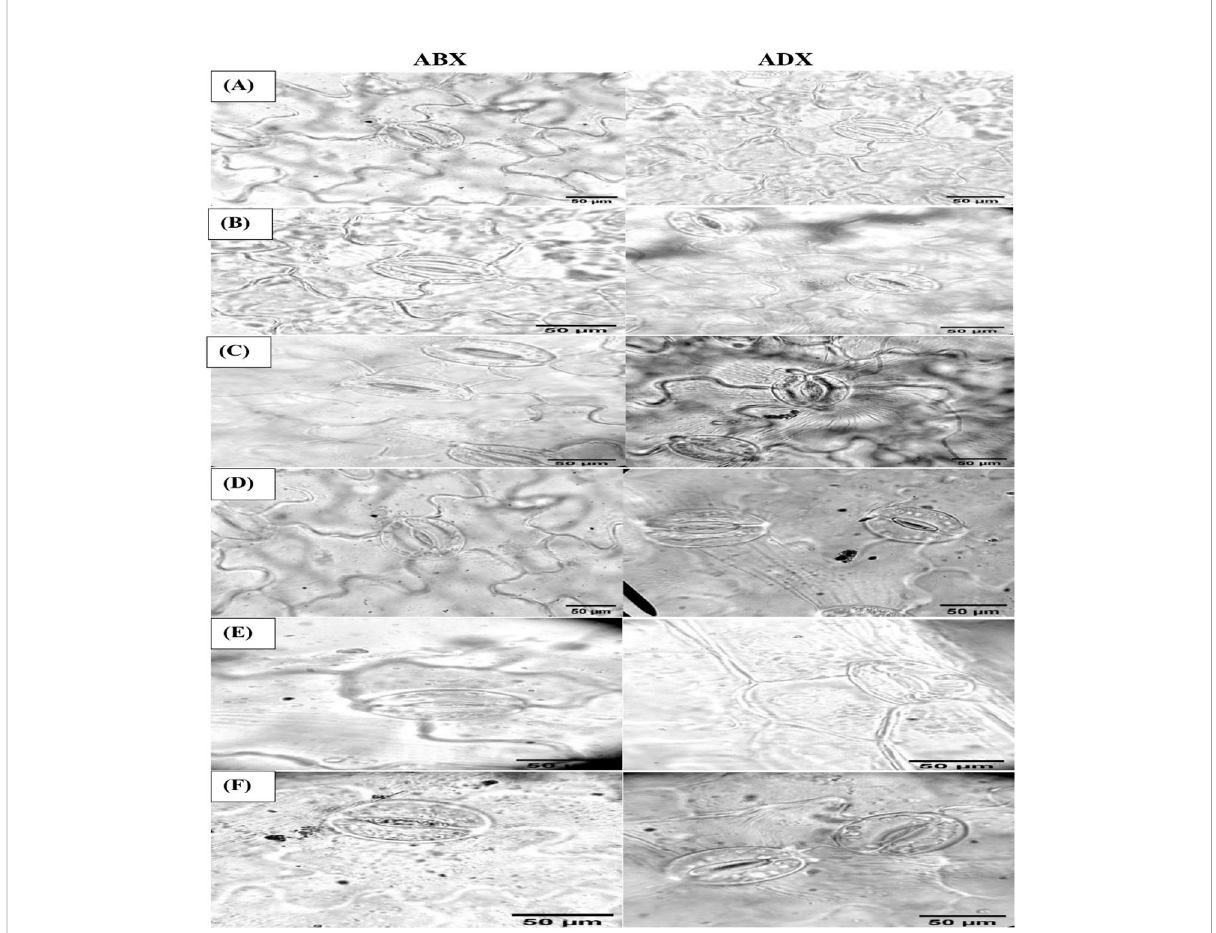
FIGURE 5 Microscopic magnitudes (×400) of the abaxial and adaxial surfaces of stomatal length, stomatal width, pore length, and pore width at different treatments: (A) TR1, (B) TR2, (C) TR3, (D) TR4, (E) TR5, and (F)